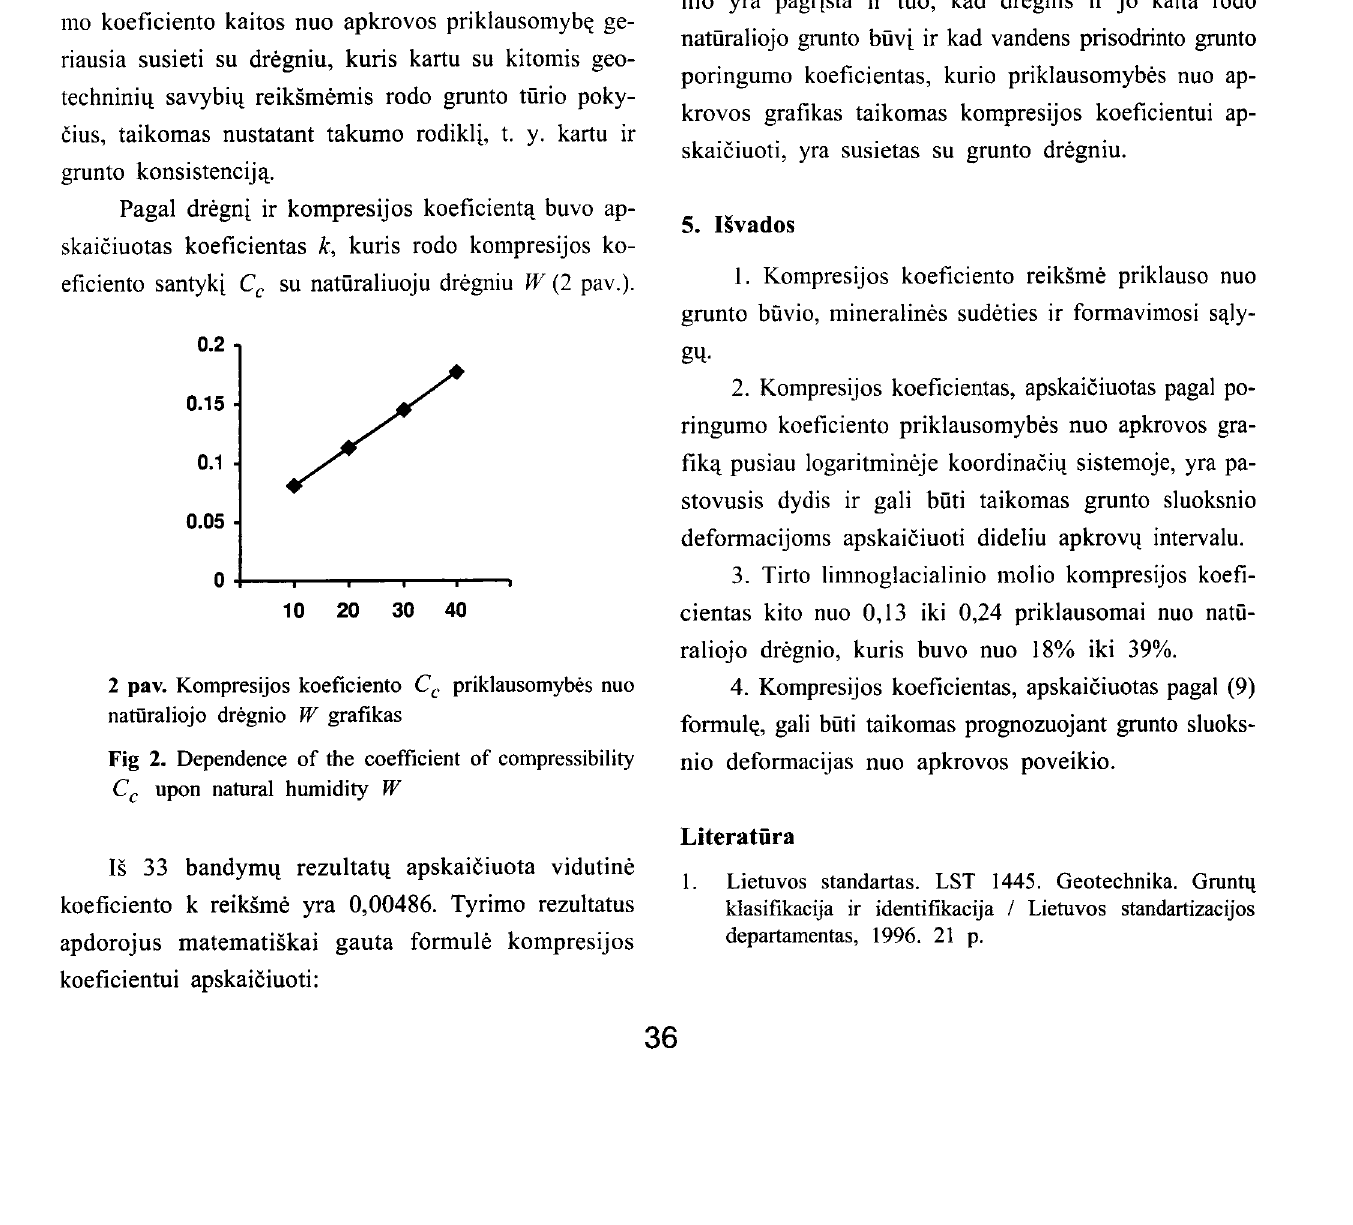
Lietuvos standartas. LST 1445. Geotechnika. Grunhl klasifikacija ir identifikacija I Lietuvos standartizacijos departamentas, 1996. 21